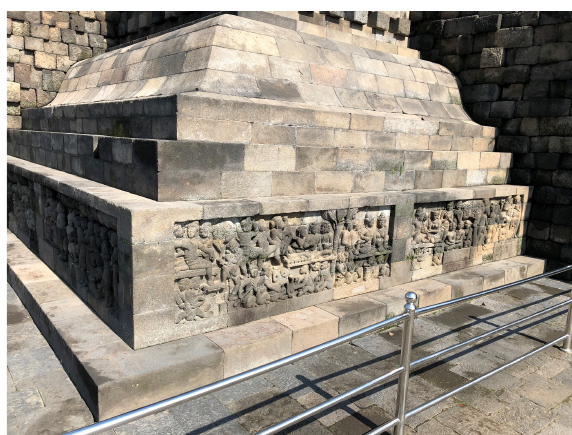
Figure 2. A photograph of our selected part of the Borobudur Temple (the area around the Karmavibhangga relief at the ground